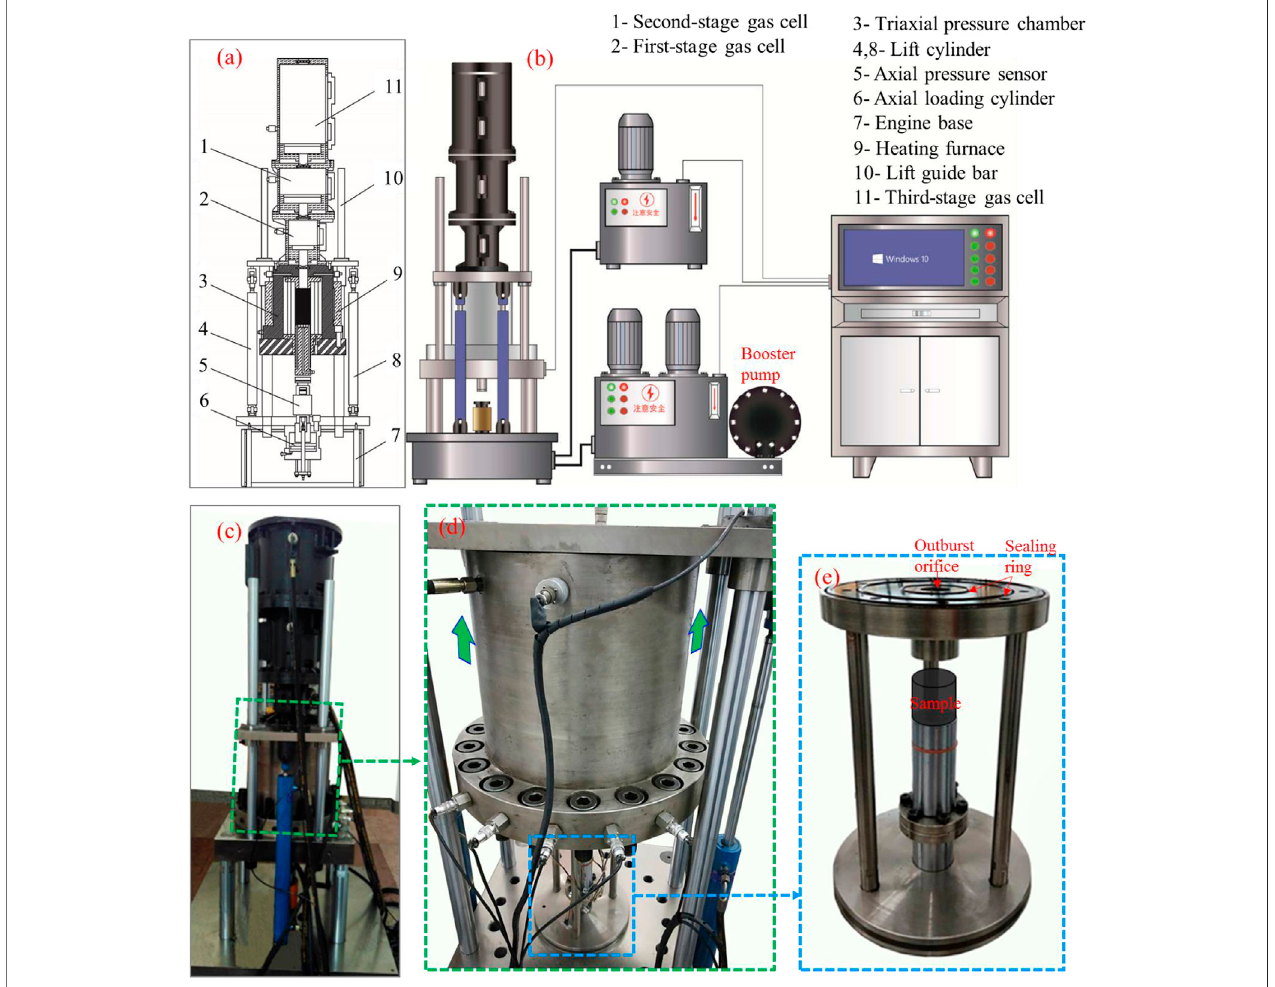
FIGURE 1 | Structure chart (A) , schematic diagram (B) and practical picture (C) of the multi-physics coal and gas outburst experimental apparatus, whose components is indicated in the structure chart. The details of the opened triaxial pressure chamber (D) and its inside (E) are enlarged (Diameter of the shown schematic sample: 50